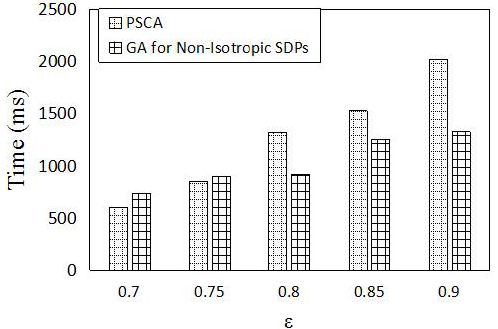
Figure 12. Computation time vs. (cid:101) . Forty sensors are uniformly deployed in a 50 m × 50 m area. The number of targets is 10, and we set p min =